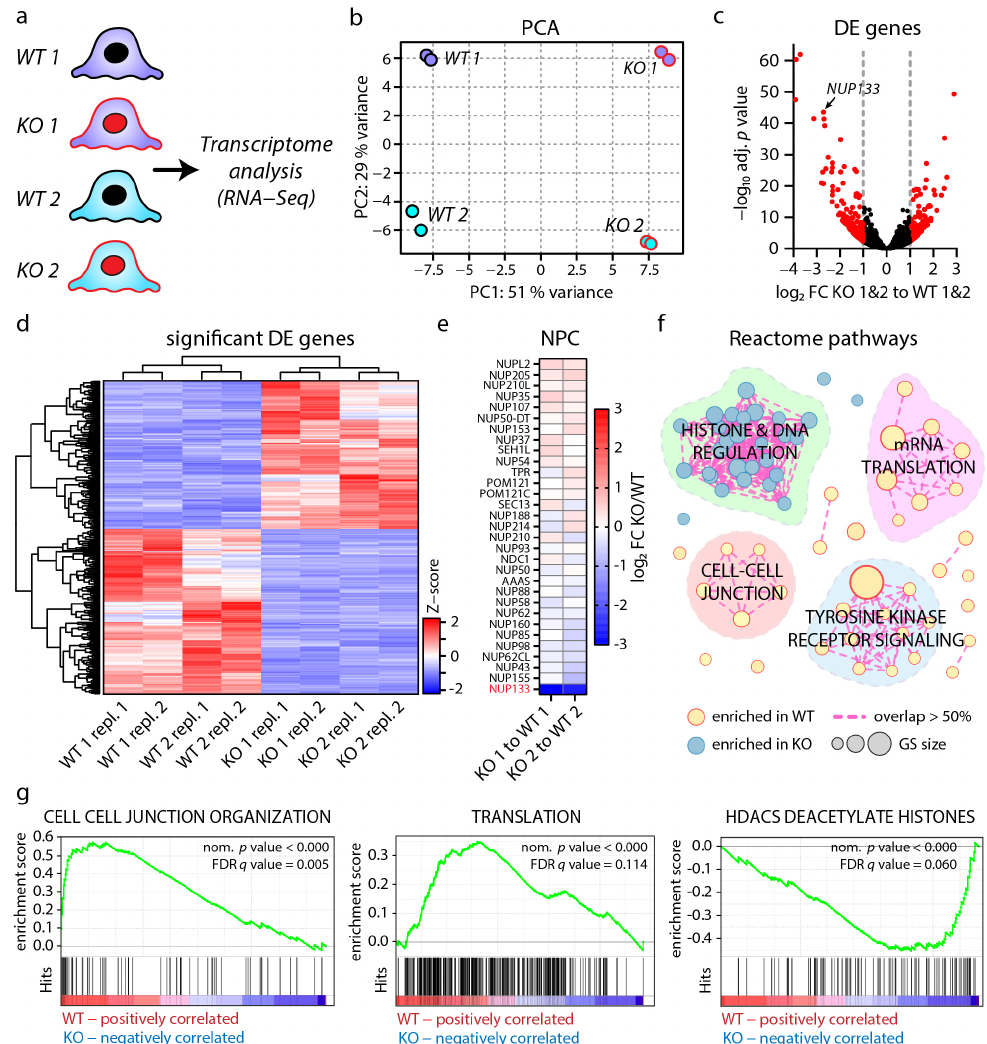
Figure 3. Loss of NUP133 remodels the transcriptome of specific regulatory pathways. ( a ) Schematic of the experimental design for transcriptome analysis (RNA sequencing). Two replicates per NUP133 genotype and clone were sequenced. ( b ) Principle component analysis (PCA) of transcriptome data (color-coding of dots/clones as in panel). ( a ) Variance of principle component 1 (PC1), mainly depending on the NUP133 genotype on both monoclonal backgrounds. ( c ) Volcano plot of combined differential expression (DE) analysis for NUP133 KO-1&2 versus WT-1&2 clones (all 4×WT and 4×KO clones were pooled for statistical analysis). Red dots indicate 324 significant (adjusted p -value < 0.05 and log2 fold-change (FC) > (abs. ± 1)) regulated transcripts. ( d ) Heat map showing Z-scores for these 324 significantly regulated transcripts, as well as unsupervised grouping for all analyzed samples. ( e ) Expression levels of NUP transcripts are not significantly altered (adj. p -value < 0.05 and log2 FC > (abs. ±1)), with the exception of NUP133 . ( f ) Gene set enrichment analysis (GSEA) for altered reactome pathways. Significantly enriched gene sets (GS) (nominal p -value < 0.01 and FRD q -value < 0.25) were clustered to a network, based on their overlap of mapped genes. ( g ) Representative GSEA plots of enriched reactome pathway gene sets are shown.